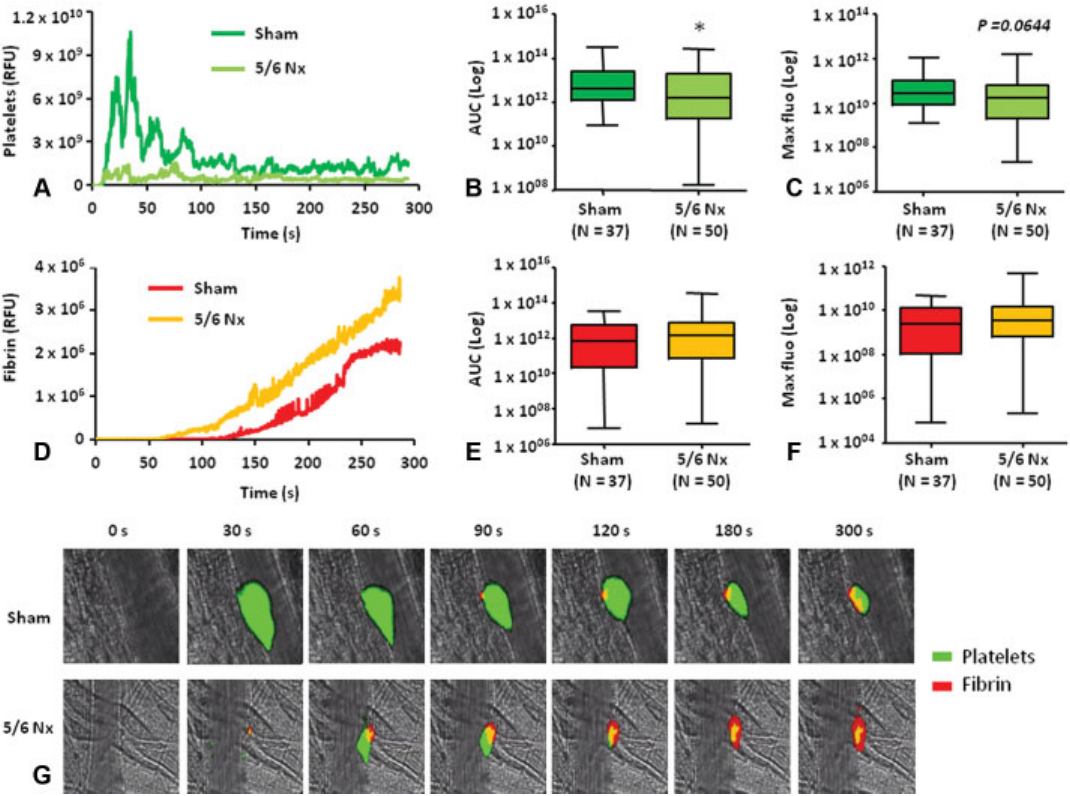
Fig. 6 Thrombus formation following laser-induced injury is affected in the CKD model of 5/6th nephrectomy in mouse. Kinetics of thrombus formation was assessed for 300seconds after the initial injury of cremaster arterioles and median-integrated fl uorescent intensities of sham- operated mice (dark green/red) and 5/6- nephrectomy mice (light green/orange) after infusion of ( A ) anti-GPIb α (platelets) and ( D ) anti fi brin ( fi brin) are plotted over time. Data using either the maximum fl uorescence ( B and E ) or AUC ( C and F ) are shown and are expressed as box plots of the indicated number of thrombi (N) obtained in fi ve mice from each group. ( G ) Representative images of intravital microscopy are shown for each condition. (cid:4) p < 0.05. anti-GPIb α ; anti-glycoprotein Ib alpha; AUC, area under the curve; CKD, chronic kidney disease; Nx, nephrectomy; RFU, relative fl uorescence units. Scale bar ¼ 10 μ